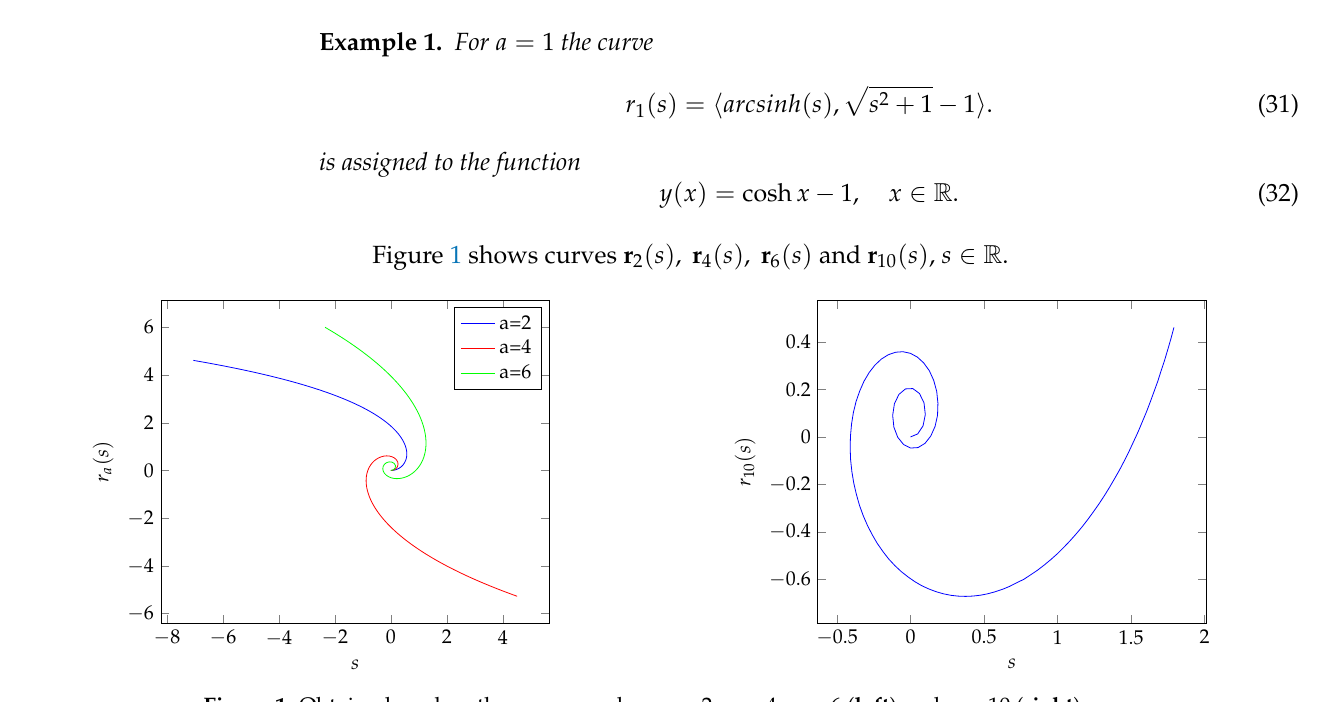
Figure 1. Obtained arc-length curves r a when a = 2, a = 4, a = 6 ( left ) and a = 10 ( right